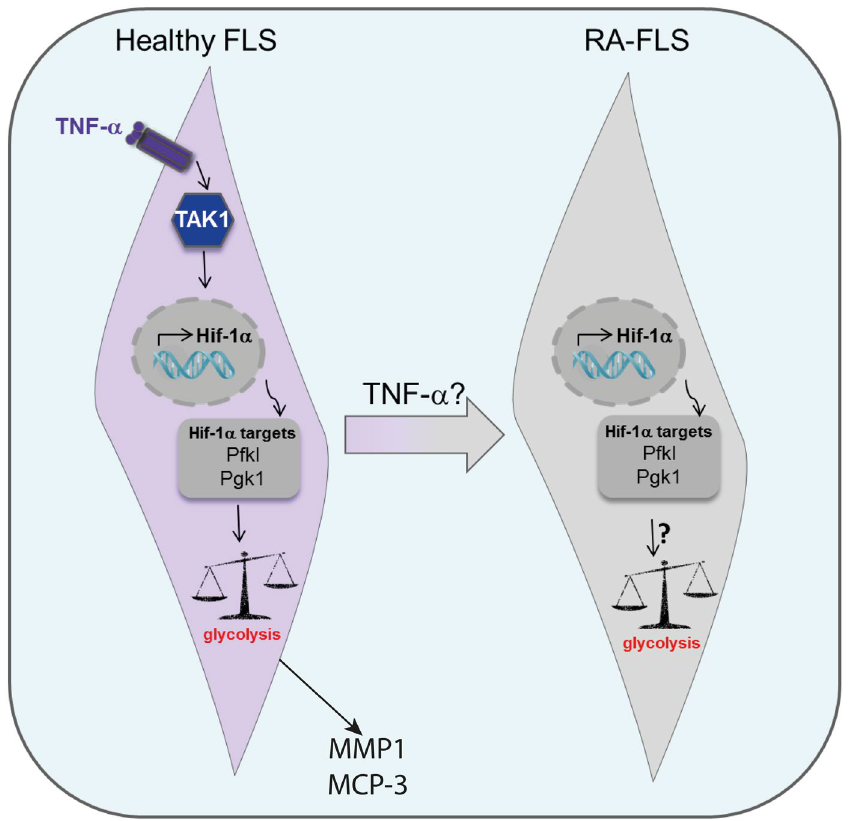
Figure 6. Hypothesis. TNF induces HIF1A and glycolytic gene expression via TAK1 in fibroblast- like synoviocytes from healthy donors, which is reflected in increased glycolysis analysed by Seahorse measurements. Inhibition of glycolysis reduces TNF-induced upregulation of RA biomarker like MMP1 and MCP-3. Similarly, FLS from RA patients showed an upregulation of these genes, leading to the hypothesis that TNF might be one of the cytokines driving metabolic reprogramming in Rheumatoid Arthritis